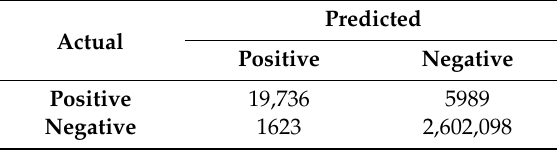
Table 3. Confusion matrix for the NDWI m